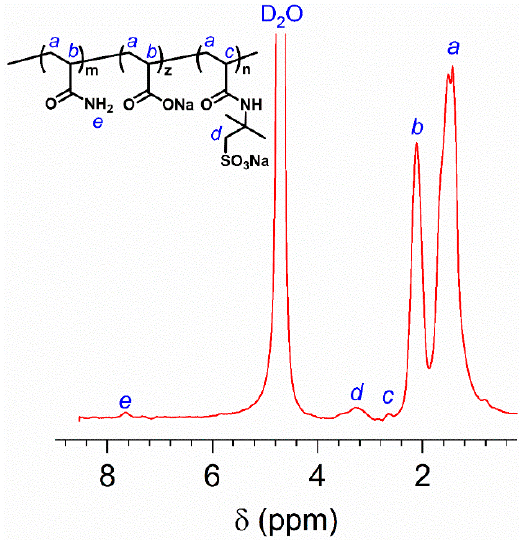
Figure 2. 1 H NMR spectrum of HVFR dissolved in D 2 O.